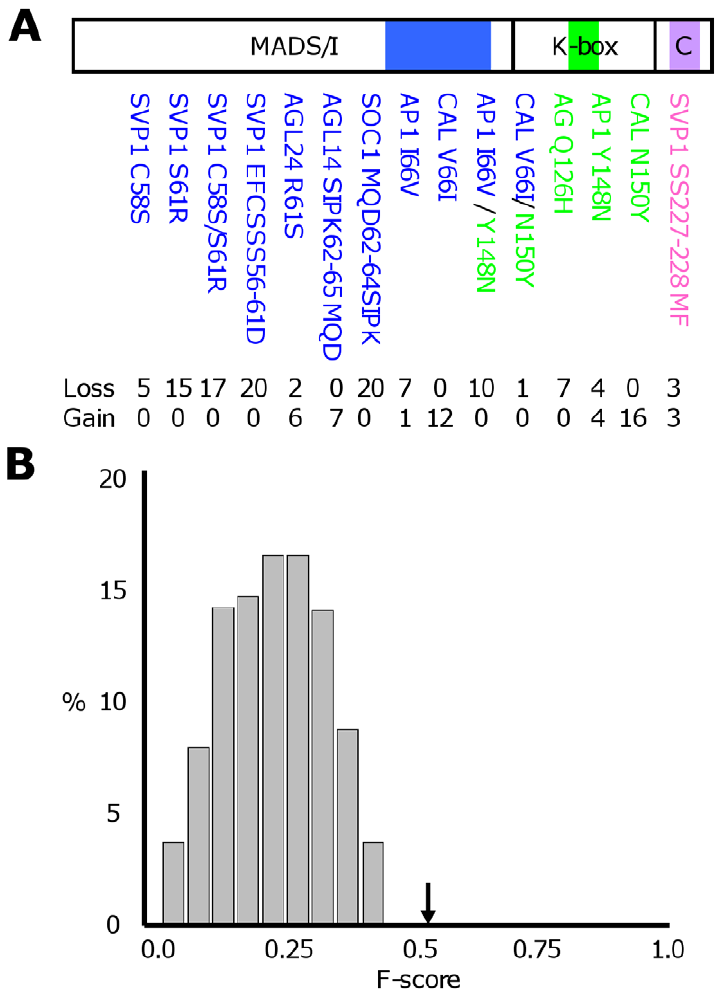
Figure 3. Effect of motif-based mutations on interaction patterns. (A) Mutations were introduced based on predicted interaction motifs as explained in Figure 2. Different domains in MIKC MADS domain proteins are shown with colored boxes indicating the various regions in which point mutations were introduced. Below these, the various mutant MADS domain proteins that were generated are listed. The descriptions of the mutated proteins are colored based on the domain in which the mutation was generated. The mutated MADS domain proteins are SHORT VEGETATIVE PHASE (SVP1), AGAMOUS LIKE 24 (AGL24), SUPPRESSOR OF OVEREXPRESSION OF CO 1 (SOC1), APETALLA1 (AP1), CAULIFLOWER (CAL), and AGAMOUS (AG). Note that there are two double mutations for which one mutation occurs in the MADS/I domain and one in the K-box. Below each mutated protein, the number of losses and gains of protein-protein interactions in the yeast two-hybrid assay for the mutated proteins in comparison to the native MADS domain proteins is indicated (see Table 1 for interaction partner identities). ( B ) Histogram of F-scores for prediction of effect of mutants based on randomized input data (see text for details). The arrow indicates the F-score obtained by the predictor trained on experimental input data.